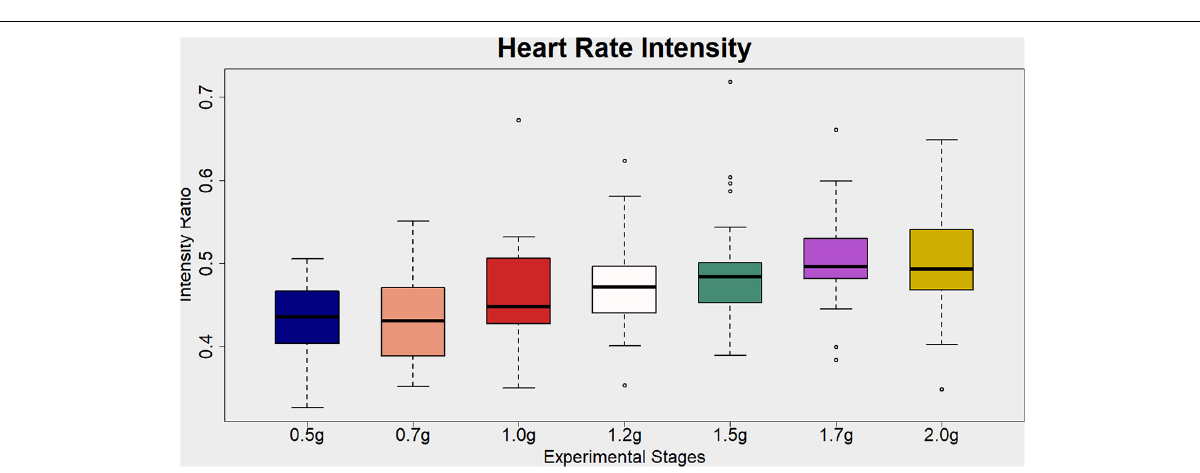
FIGURE 4 | Visualization of the Heart Rate Intensity ratio (%) for each artificial gravity (AG) condition. This is a cardiovascular index of the exercise intensity level. It is estimated as the heart rate (beats per minute) during each training phase divided by the maximum heart rate (MHR) intensity. The MHR for each participant is defined as 220-participant’s age. Ratio values ranging from 40 to 59% are indicative of light